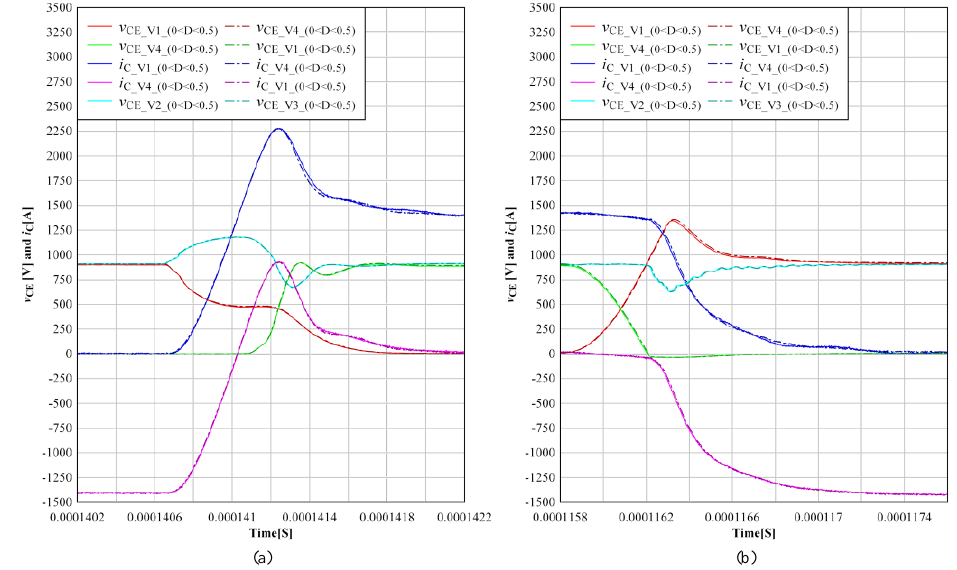
Figure 21. Influence of active switch position of outer commutation loop. ( a ) Detail waveforms of IGBT and FWD during IGBT turn-on. ( b ) Detail waveforms of IGBT and FWD during IGBT turn- off.